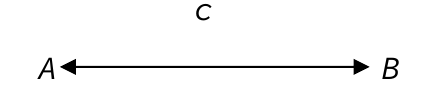
Figure 4. A basic fundamental triad or a basic named set.